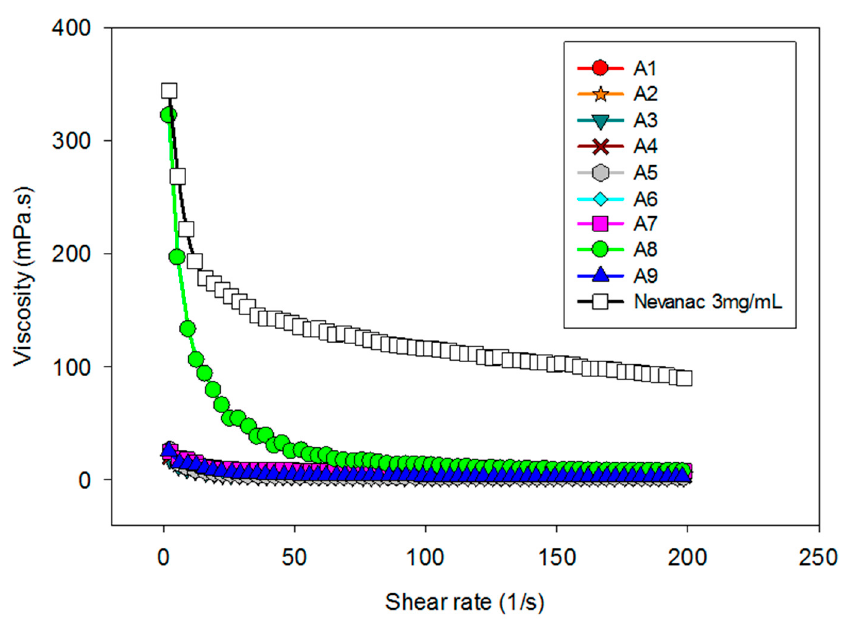
Figure 2. Dependence of viscosity on shear rate conditions of eye drops measured at 37 °C.